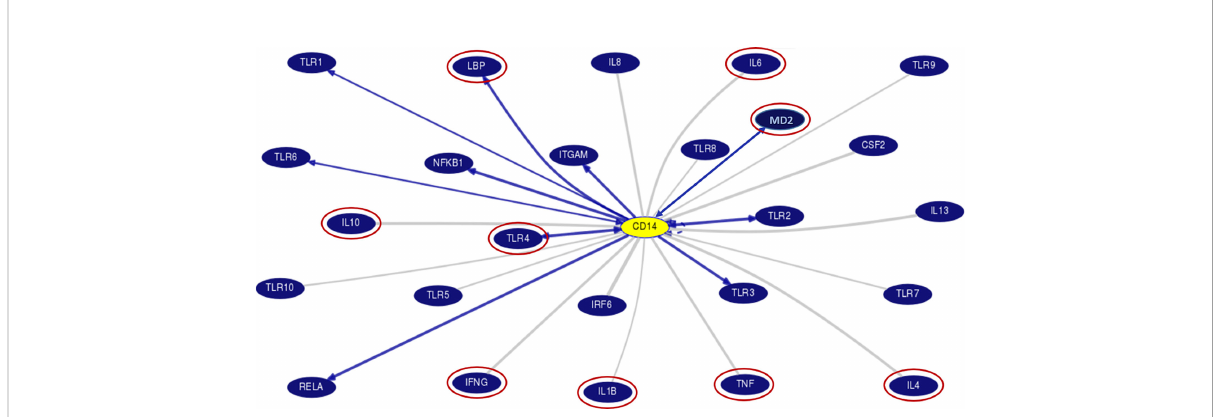
FIGURE 3 Gene interaction model of CD14 gene with other genes as generated/adapted by using “ Gene Interactions ” track of UCSC genome browser (www. genome.ucsc.edu) based on curated pathway/protein-interaction databases and interactions found through text mining of PubMed articles (https:// genome.ucsc.edu/goldenPath/help/hgGeneGraph.html). The interaction of CD14 with other proteins is arrow marked. The red circle proteins are studied in the serum of patient samples. CD14, Cluster of differentiation 14, CSF2, Colony stimulating factor 2; IFN, Interferon; IL, Interleukins; IRF6,